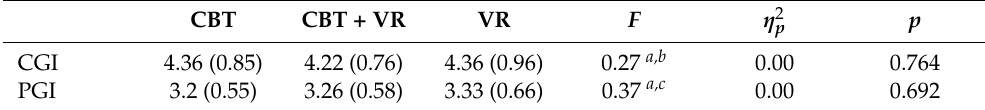
Table 4. Means, standard deviations, and ANOVA results for CGI and PCGI at T0.